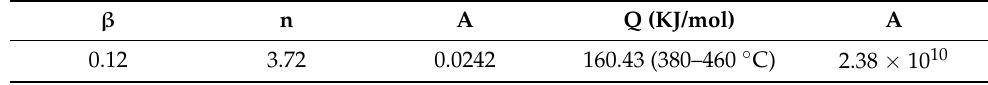
Figure 5. Comparison of peak stress between experiment value and predicted value. 3.2. Hot Processing Map The dynamic material model (DMM) is commonly used to construct the processing map of the aluminum alloys [24]. This model combines the external energy with the en- ergy consumed during the hot deformation process. When the material is deformed, the energy required for microstructure evolution is usually expressed by power dissipation efficiency η, which is defined as follows [25]: η = J/J (cid:2923)(cid:2911)(cid:2934) = 2m/(1 + m)